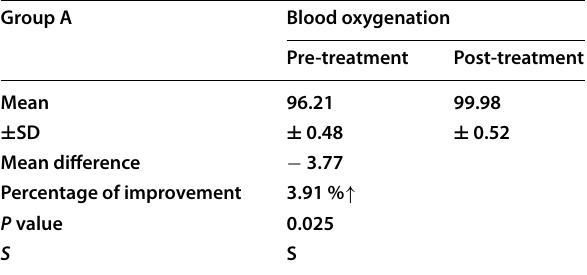
Table 3 Mean values of blood oxygenation pre- and post- treatment of group